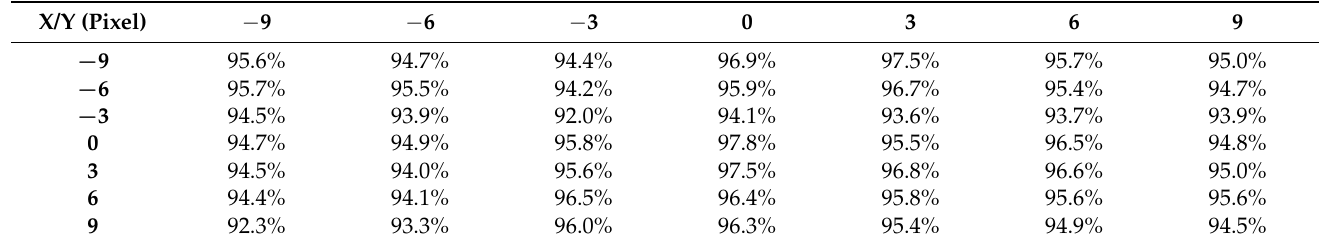
Table 4. Classification accuracy at different offsets (T72_BMP2_BTR70